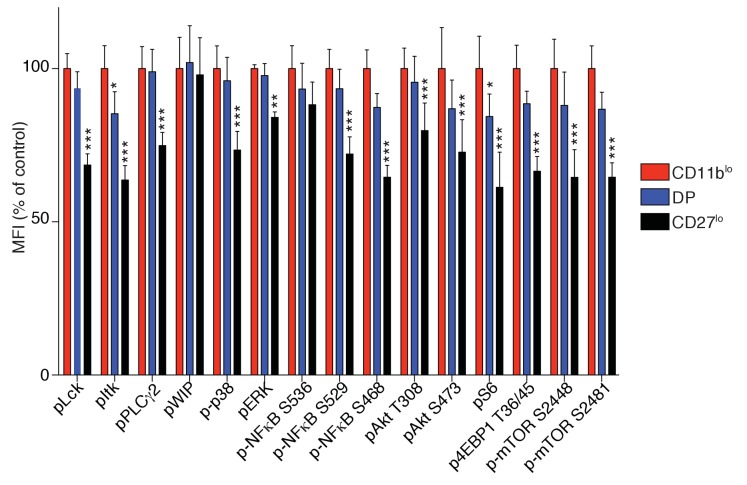
Bar graph showing the phosphorylation level of the indicated phosphoepitopes in the different subsets of splenic resting C57BL/6 NK cells defined by their expression of CD27 and CD11b.Mean Fluorescence Intensity was recorded for each phosphoepitope in each subset. Normalized expression was calculated using the CD27+CD11blo subset of C57BL/6 mice as reference (n = 6 mice in three independent experiments, two-way ANOVA comparing the indicated subset with the CD11blo subset, *p<0.05, **p<0.01, ***p<0.001).